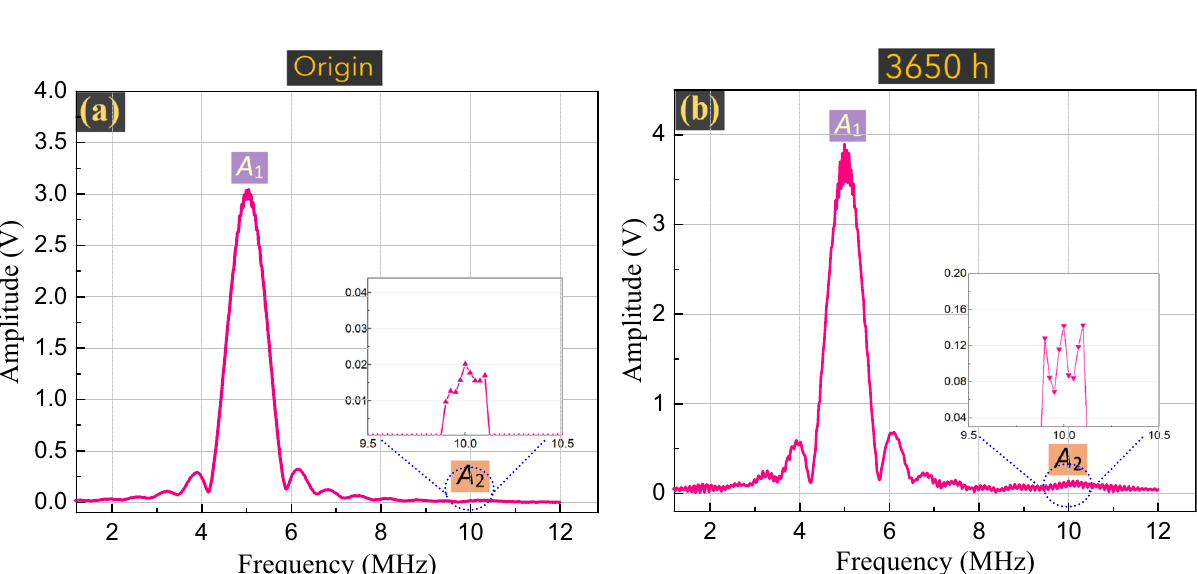
Figure 5: The curve of the frequency spectrum of the TP347HFG steel: ( a ) origin specimen and ( b ) aging for 3,650